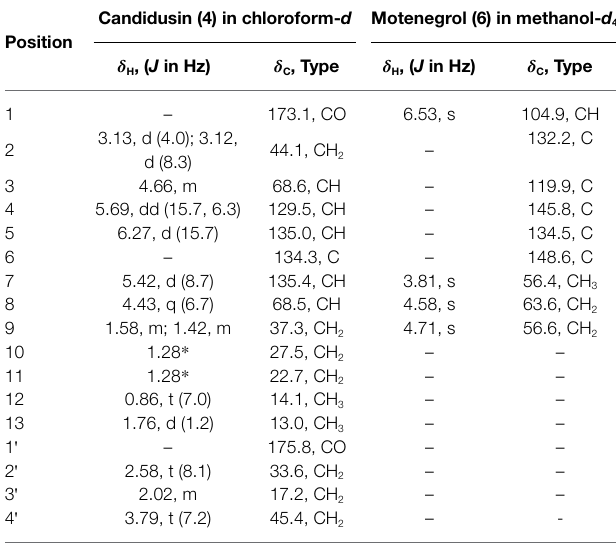
TABLE 2 | The 1 H and 13 C NMR data (500 and 125 MHz) for new compounds 4 and 6 . Candidusin (4) in chloroform- d Motenegrol (6) in methanol- d Position